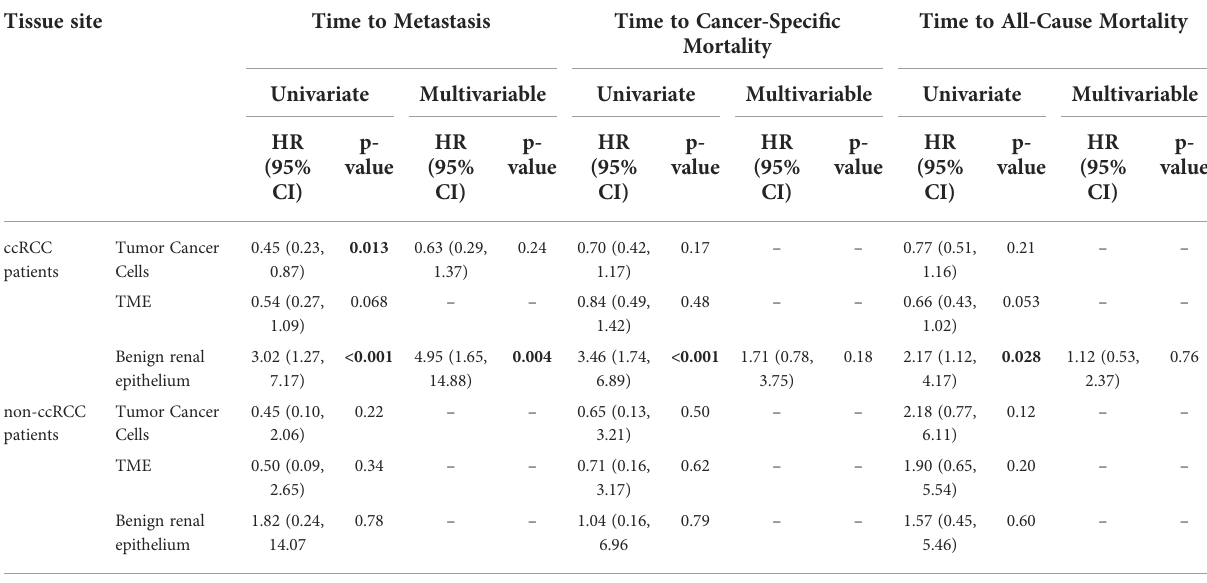
TABLE 2 Association between tissue iron levels and RCC patient survival